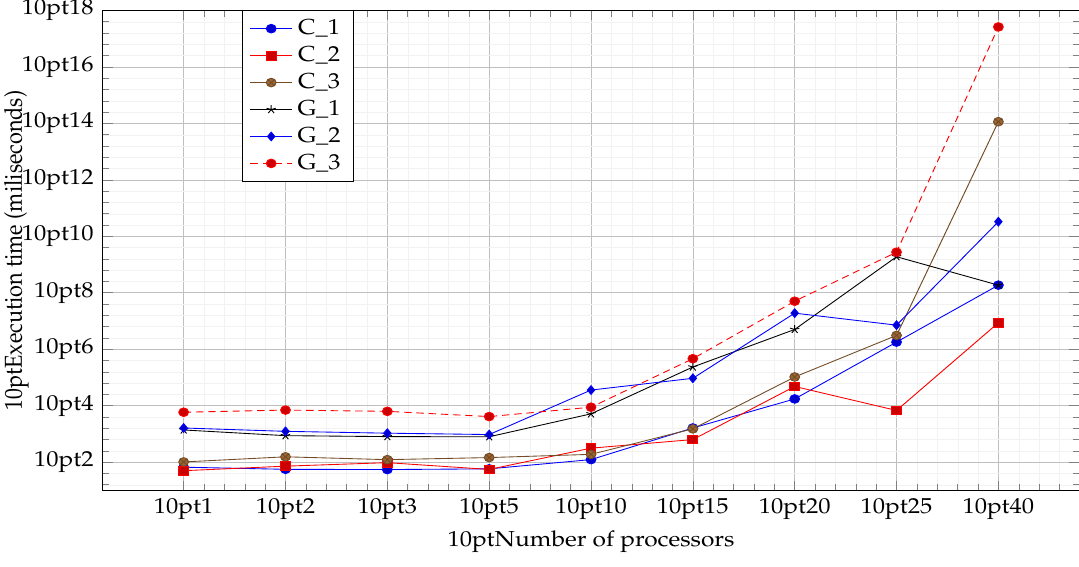
Figure 3. Computational time solving a unique LP problem in multiple processors using CPLEX and GUROBI solvers. The evaluated problems are: Size 1 with CPLEX (C_1), Size 2 with CPLEX (C_2), Size 2 with CPLEX (C_3), Size 1 with GUROBI (G_1), Size 2 with GUROBI (G_2) and Size 3 with GUROBI